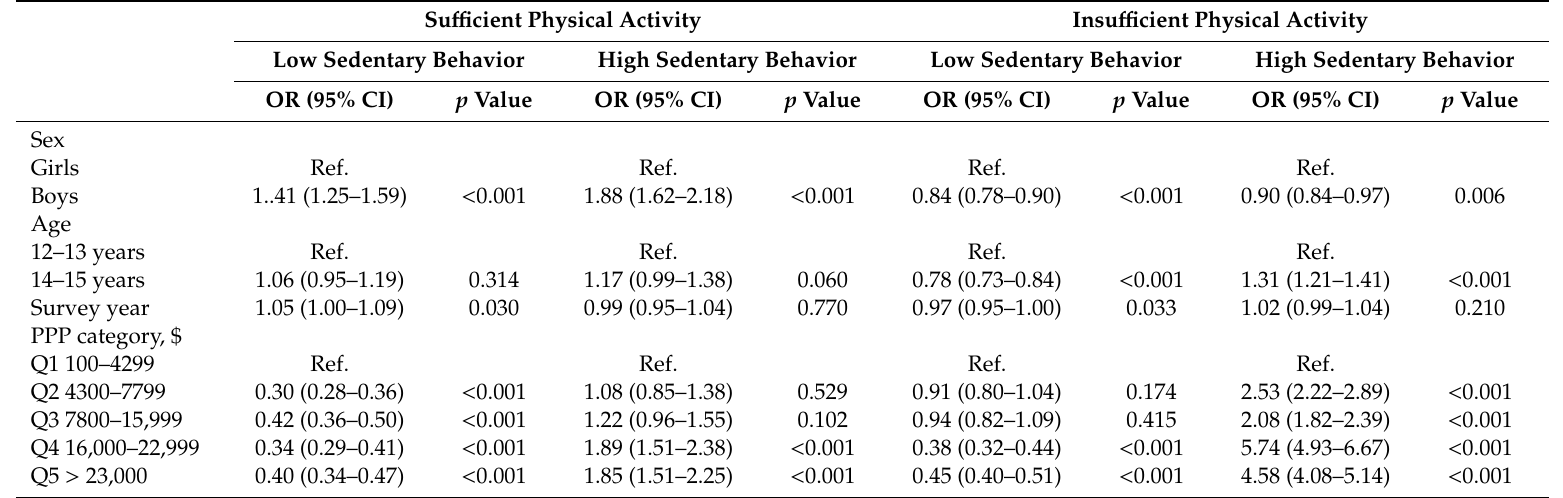
Table 6. Predictors of insu ffi cient physical activity and of high sedentary